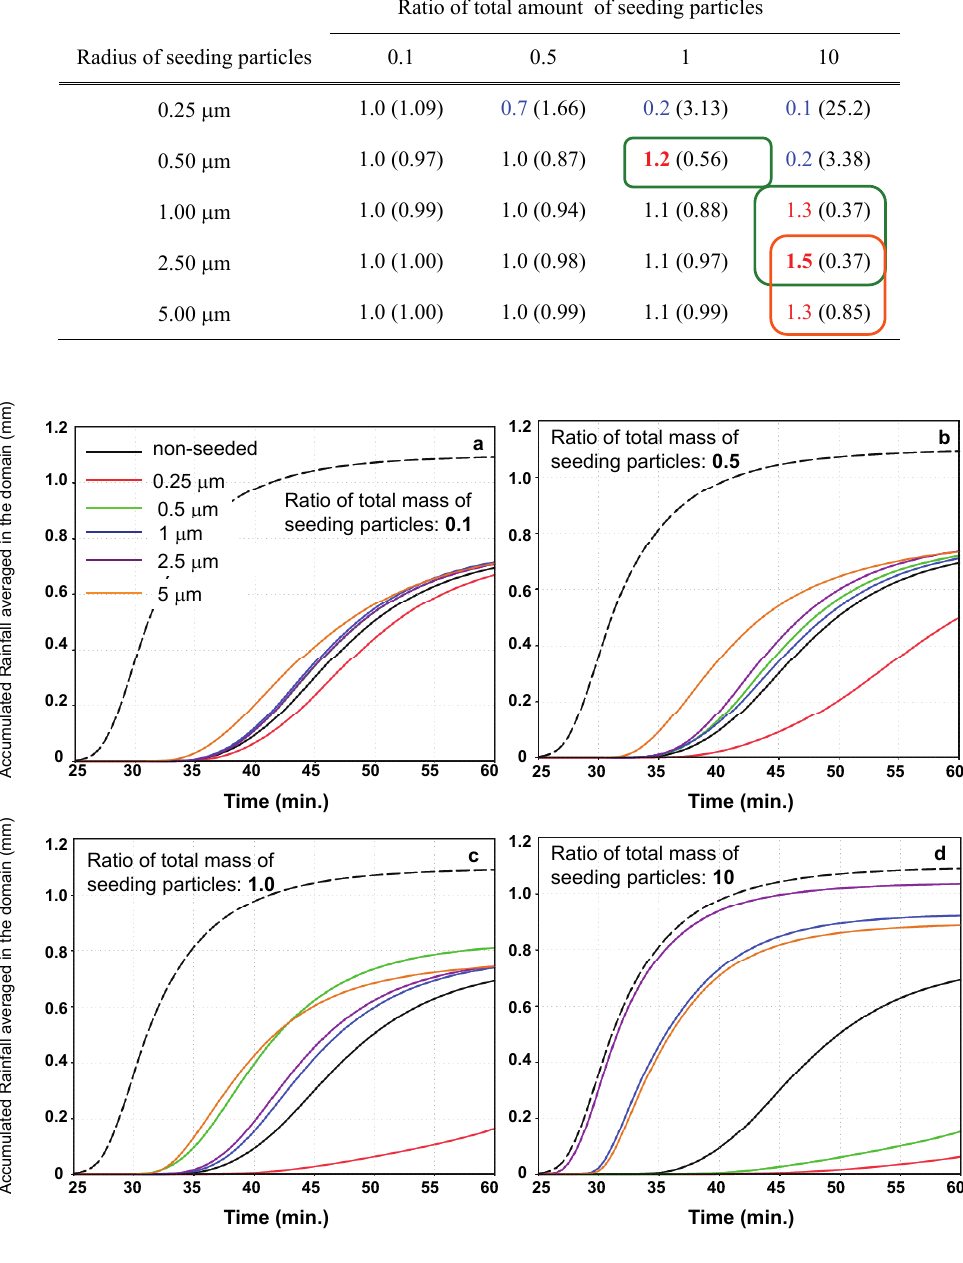
Fig. 7. Temporal change of accumulated surface rainfall averaged over the domain for the shallow convective cloud case. In each panel, the black solid line indicates accumulated surface rainfall for the non-seeded case. For seeded cases, monodisperse salt particles with five different radii are seeded under the cloud base: 0.25µm (red line), 0.5µm (green line), 1µm (blue line), 2.5µm (purple line), and 5µm (orange line). Ratios of the total amounts of seeding particles to the reference are 0.1 (a) , 0.5 (b) , 1.0 (c) , and 10 (d) . Number concentrations of seeding particles are shown in Table 1. For reference, accumulated surface rainfall from a non-seeded maritime cloud is also shown in each panel by a black broken